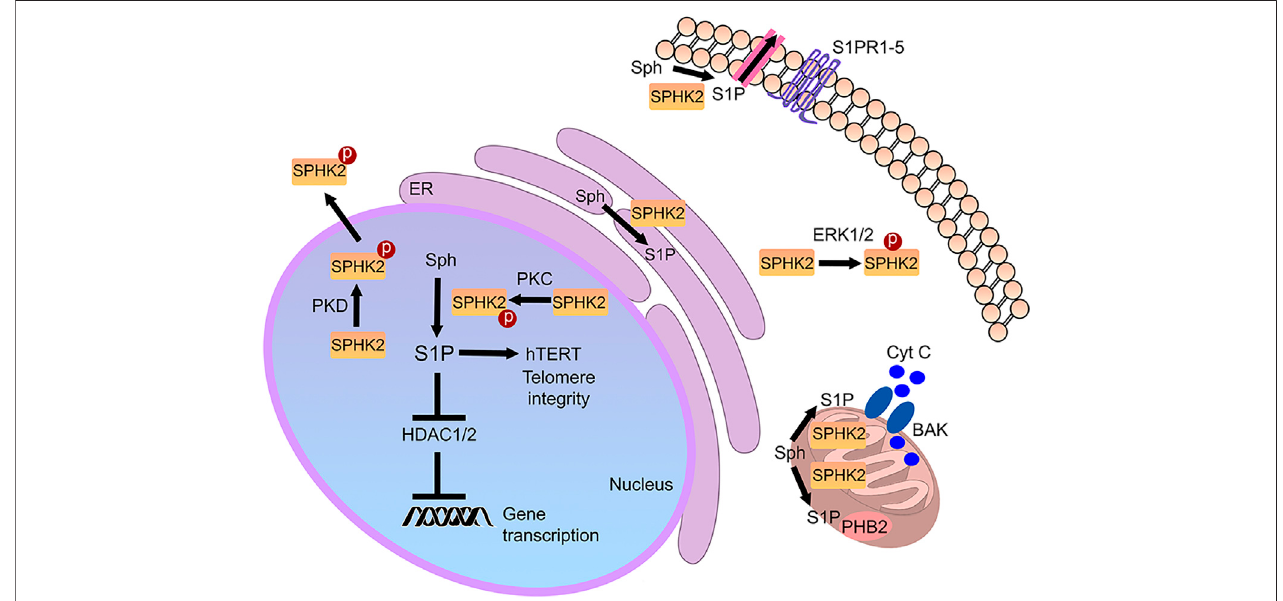
FIGURE 2 | Cellular SPHK2-associated pathways. S1P generated by SPHK2 is localized to multiple sites in the cell. In the nucleus, it modulates gene expression andtelomereintegrity.Inthemitochondria,itmayregulateprohibitin2(PHB2)andBaxandBakactivation(BAK).Intheendoplasmicreticulum(ER),itregulatescelldeath pathways.Incancer,SPHK2may berecruited totheplasmamembrane,where itgeneratesS1P.Secreted or transported S1Pthenbinds toS1PRs inan autocrineand paracrine